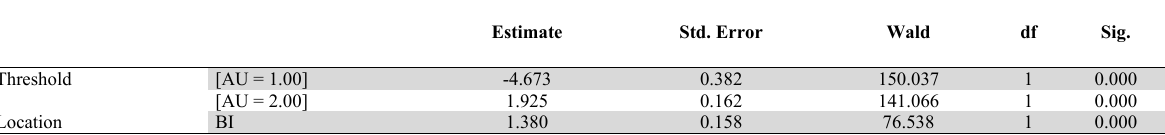
Ordinal Logistic Regression Analysis: Parameter Estimates Result Estimate Std. Error